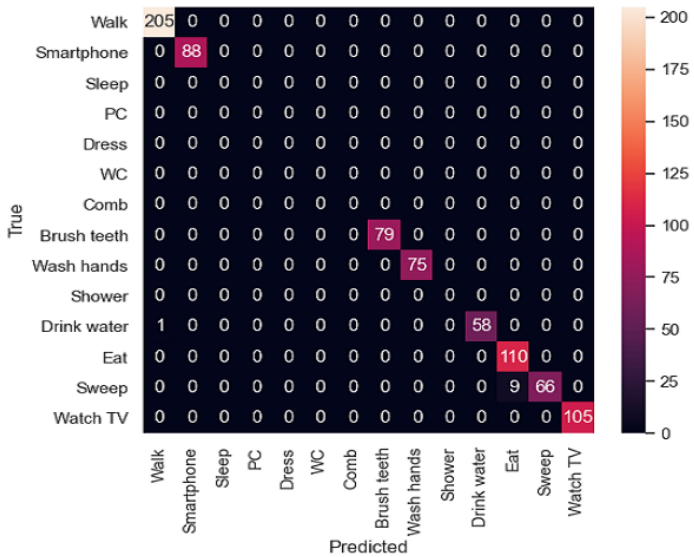
Figure 26. Sequence 2-Experiment 2-Confusion